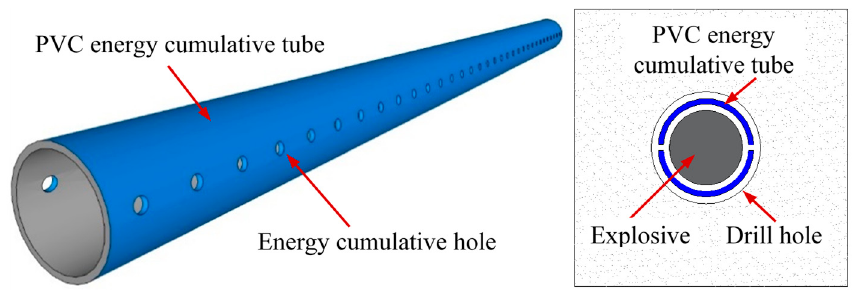
Figure 6. Polyvinyl chloride energy cumulative tube and radial charge structure.